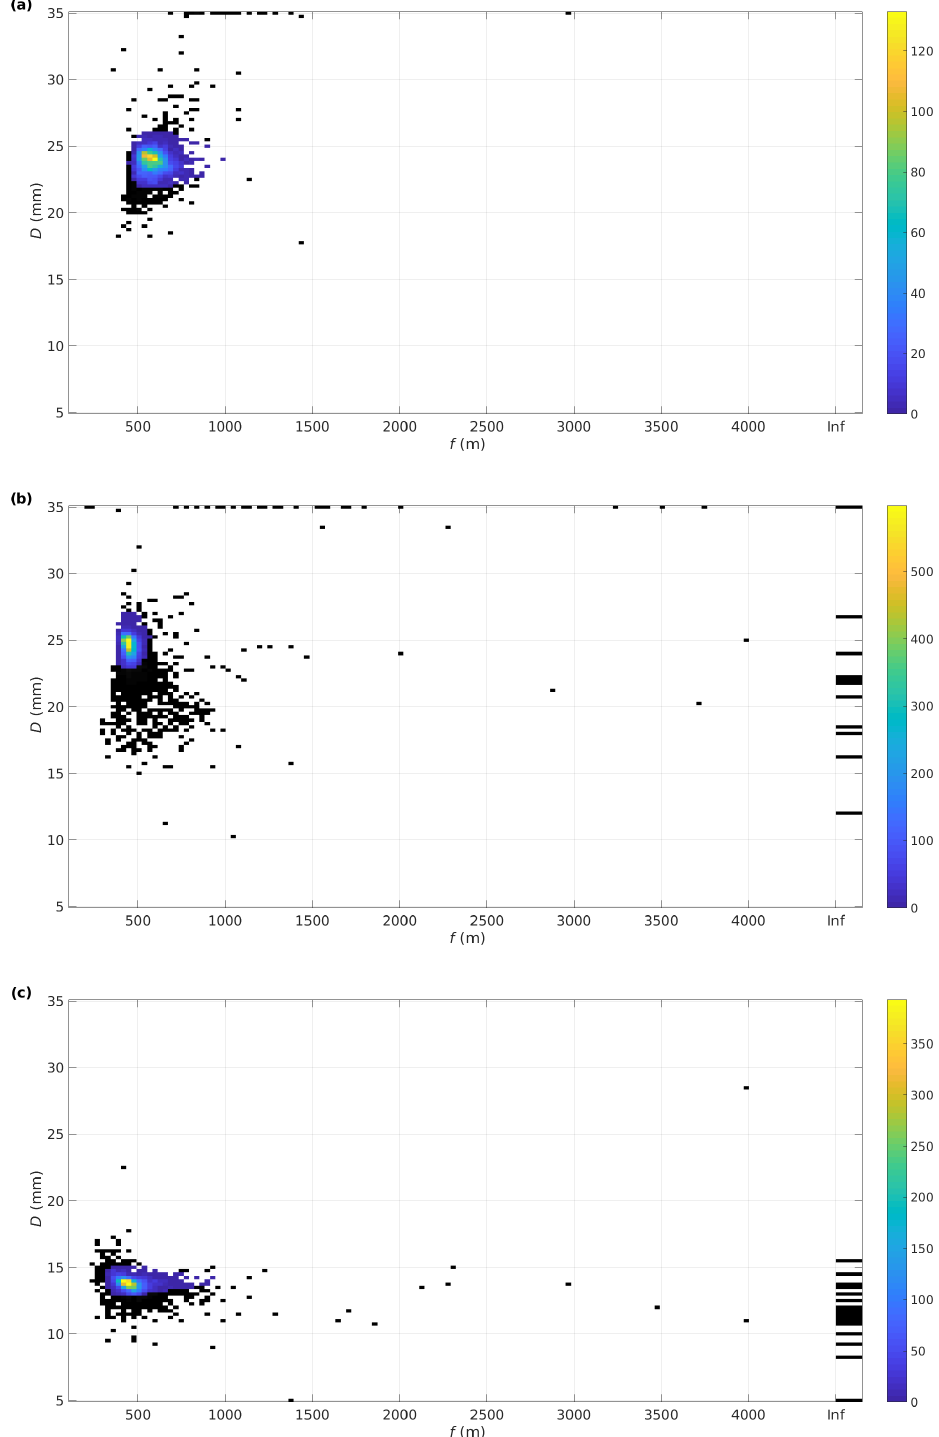
Figure 3. Distributions of T f (R) parameter estimates from (a) Darwin from 21 June 2011 to 22 July 2012, (b) SGP from 1 January 2015